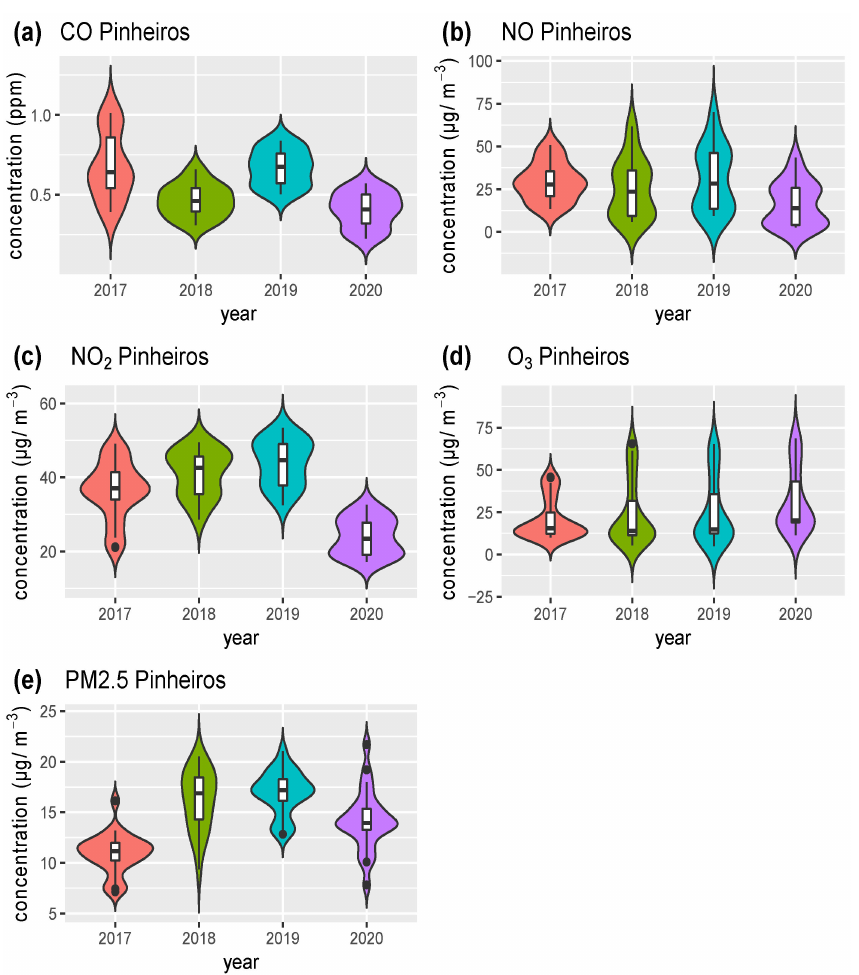
Figure 16. Violin graphs for Pinheiros station during April to May of 2017 to 2020 from ground